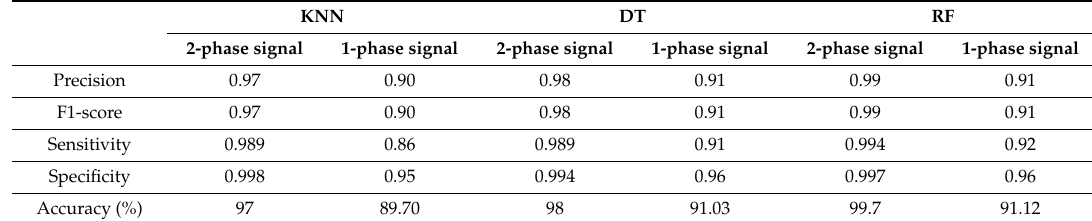
Table 7. Comparing evaluation parameters of one-phase and two-phase current signal.